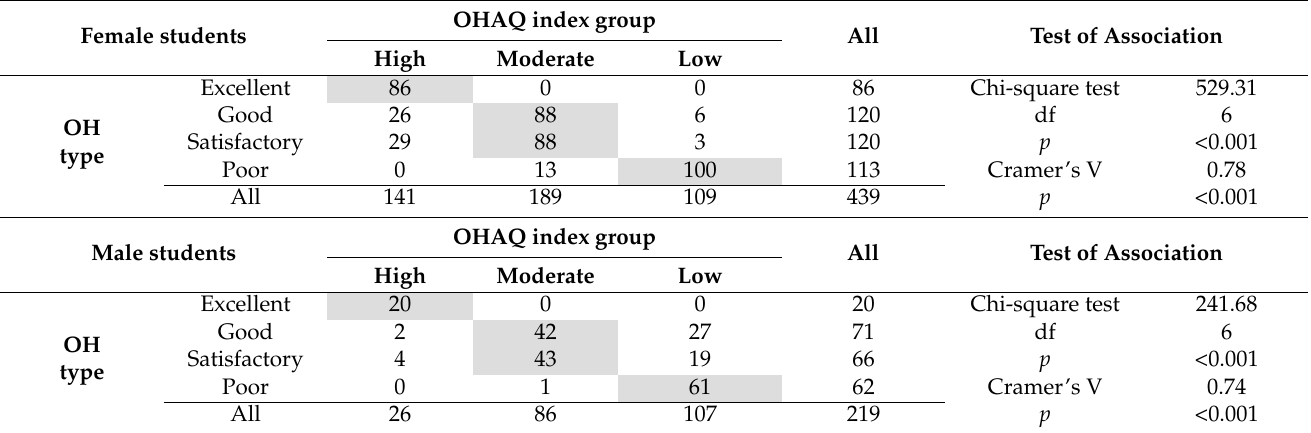
Table 10. Association of OHAQ type and OHAQ index variables for female and male